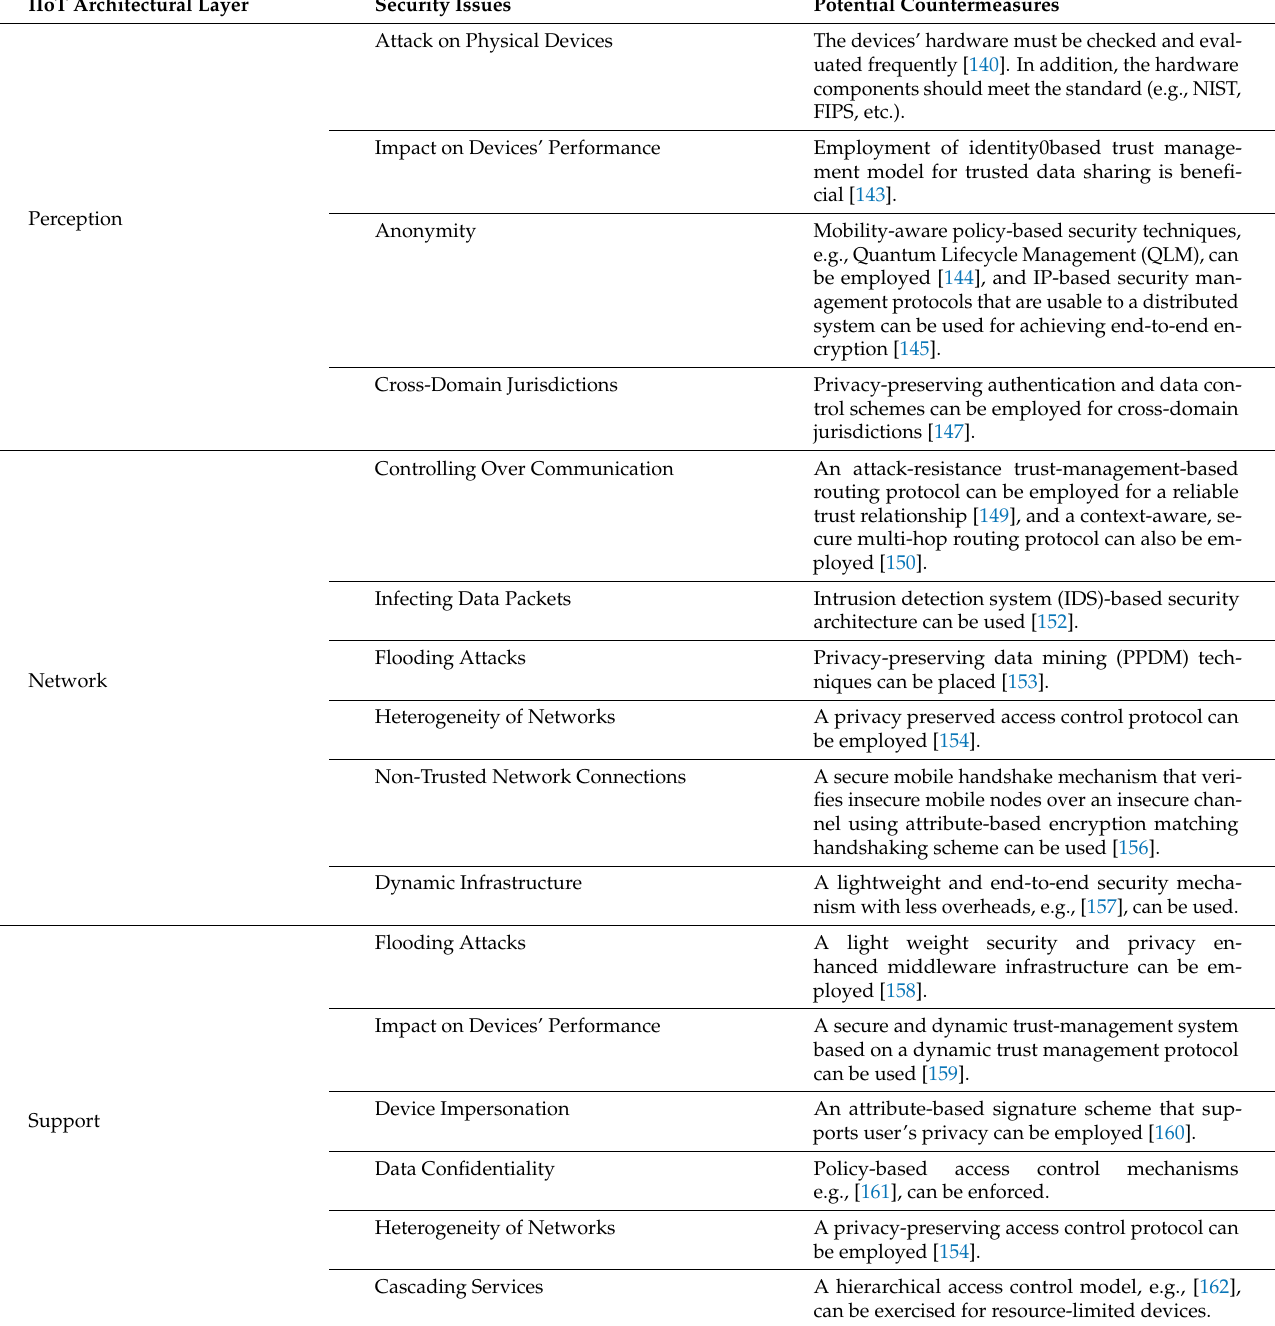
Table 1. Identified security issues and their potential countermeasures in different layers of an IIoT